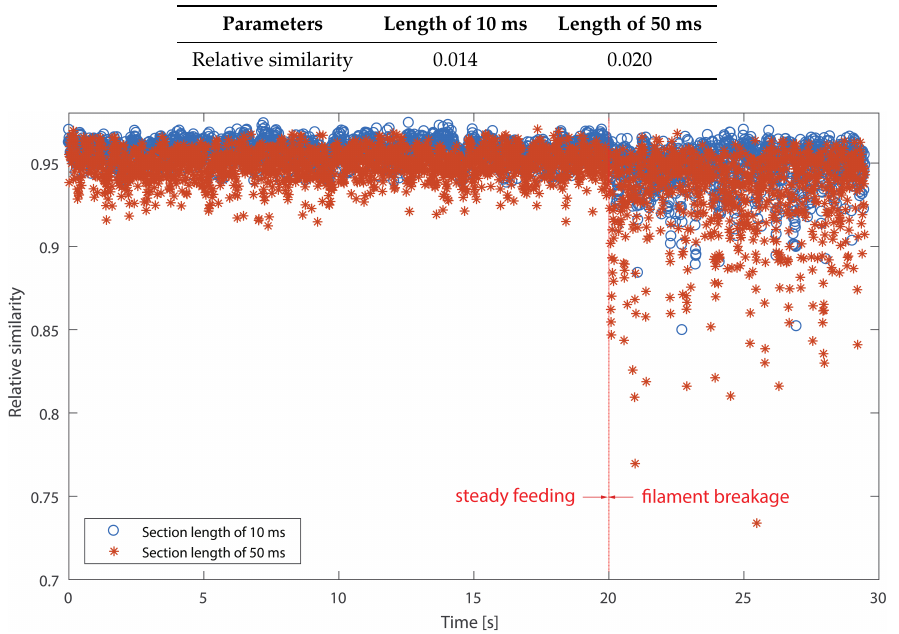
Figure 14. Relative similarity results using different time sections for Test